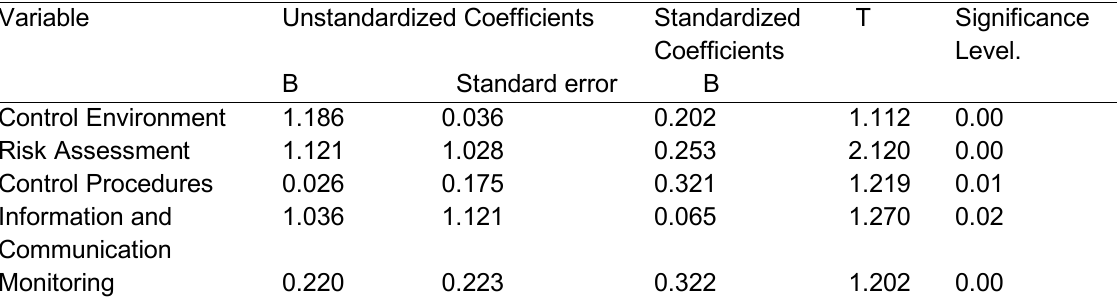
Table 6: Internal Control and